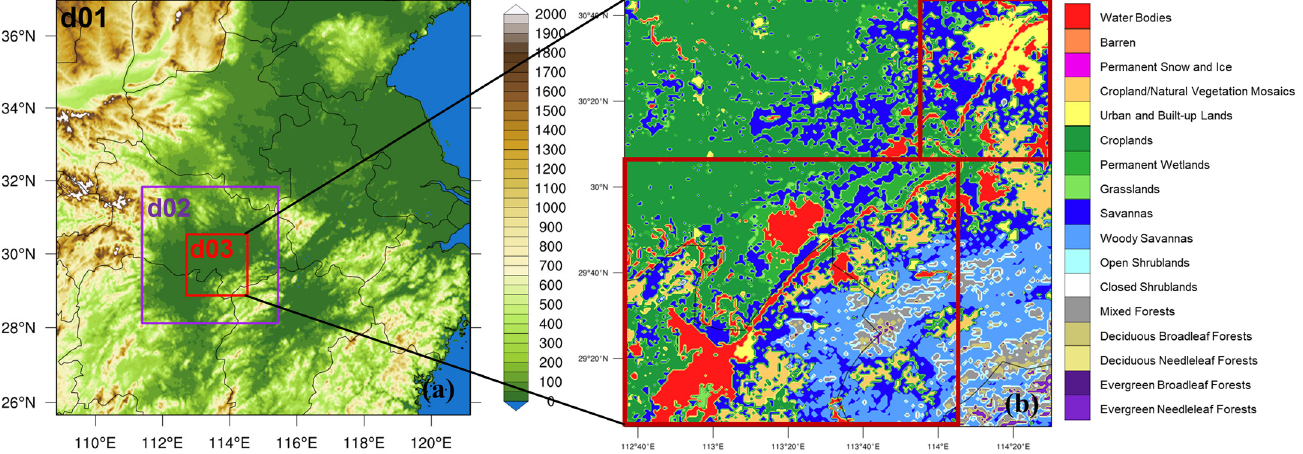
Figure 1. ( a ) Three nested domains d01, d02, and d03 (in different boxes) and topographical height above sea level (color contours, unit: m) for WRF-Chem simulation; ( b ) land use type in the domain d03. The big box in the lower left corner of d03 denotes the centralized big lakes (CBLs) Dongting Lake and Honghu Lake, and the small box in the upper right corner denotes the discrete small lakes (DSLs) around Wuhan.